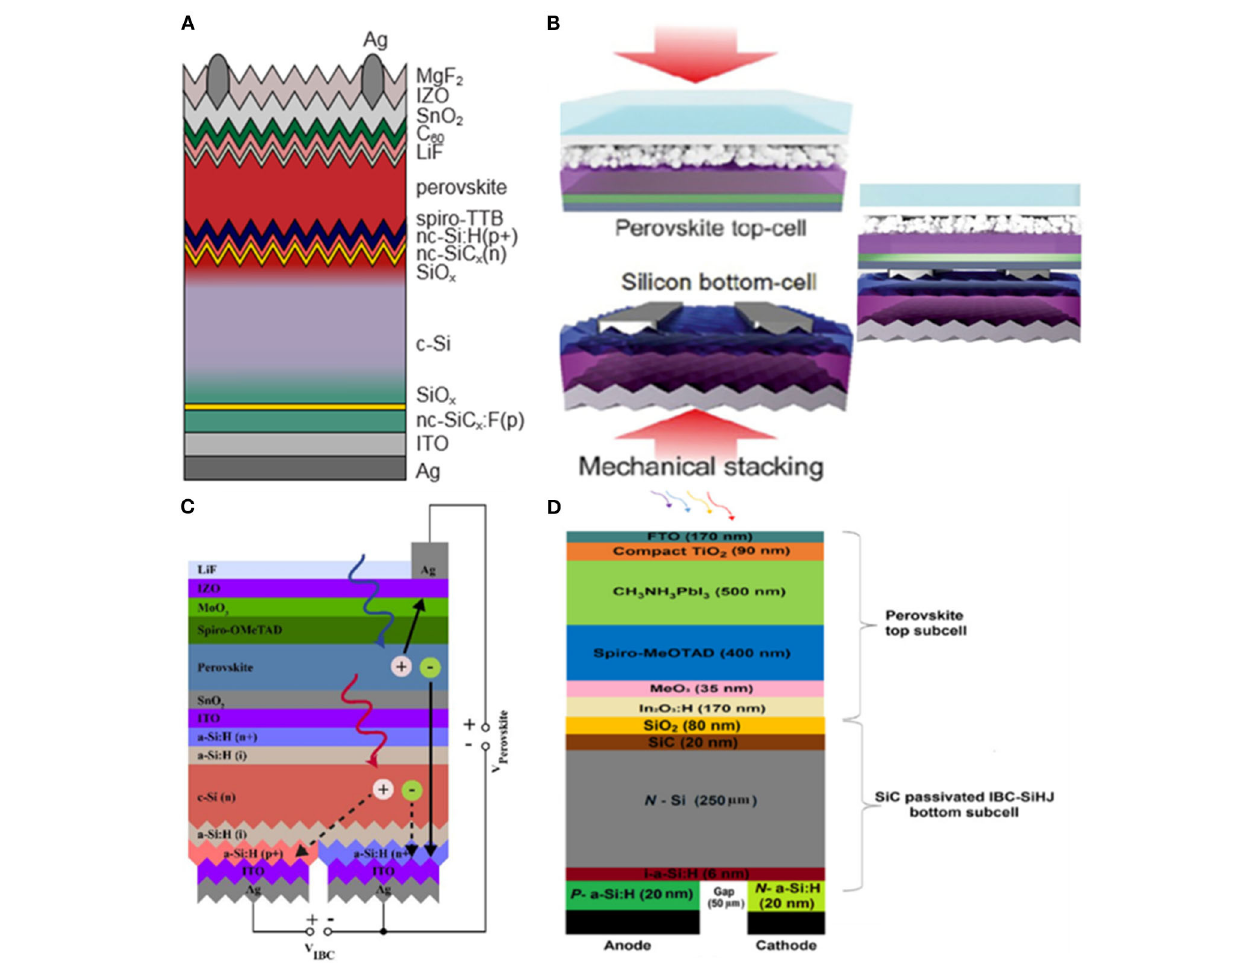
FIGURE 13 | (A) Schematic view of the PVSK/p-type c-Si bottom cell (reproduced from ref. 85, copyright 2019, ACS). (B) Obtaining the 2T PVSK/Si tandem solar cell by mechanical stacking of subcells by applying pressure over their contact area (reproduced from ref. 86, copyright 2019, Elsevier Inc.). (C) Schematic drawing (not to scale) of IBC 3T tandem solar cell and its operating principle (reproduced from ref. 87, copyright 2020, ACS). (D) Device structures used in simulation of mechanically stacked PVSK/IBC-SiHJ tandem cells (reproduced from ref.88, copyright 2017, SPIE).